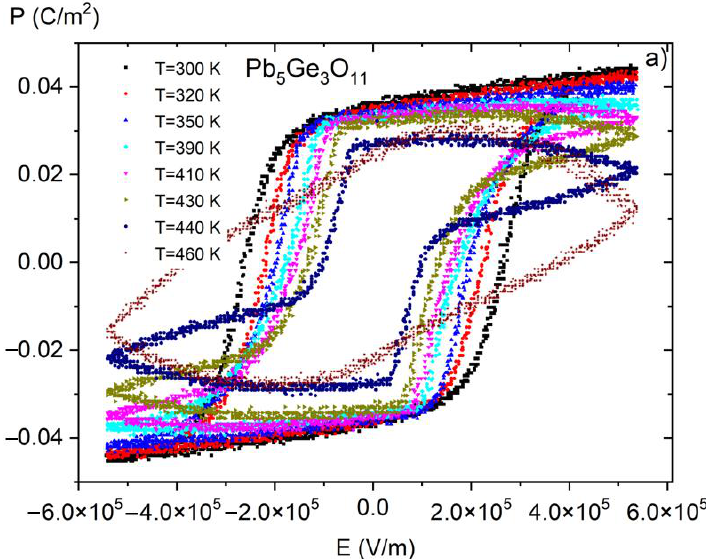
Figure 8. P ( E ) (polarization-electric fields) hysteresis loops as a function of temperature for pure PGO crystal. Reproduced from [10] with permission from the Royal Society of Chemistry.